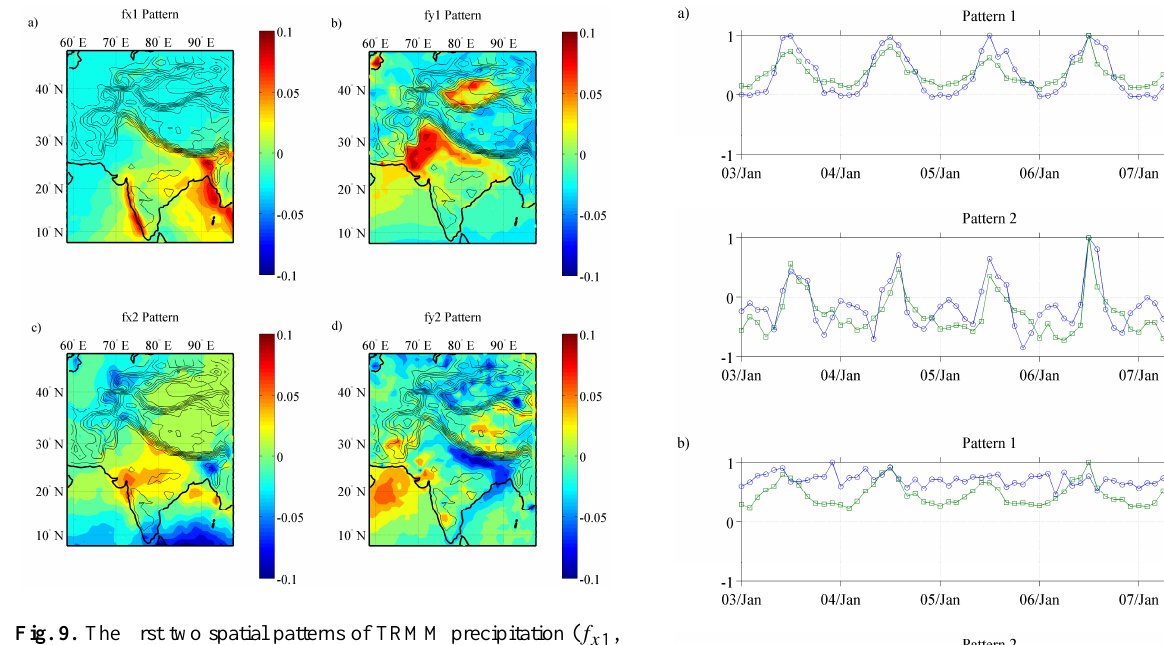
Fig. 9. The first two spatial patterns of TRMM precipitation ( f x 1 , f x 2 ) and MODIS AOD ( f y 1 , f y 2 ) that explains the maximum co- Figure 9: The first two spatial patterns of TRMM precipitation (fx1,fx2) and MODIS variance between the two fields. AOD (fy1,fy2) that explains the maximum covariance between the two fields.